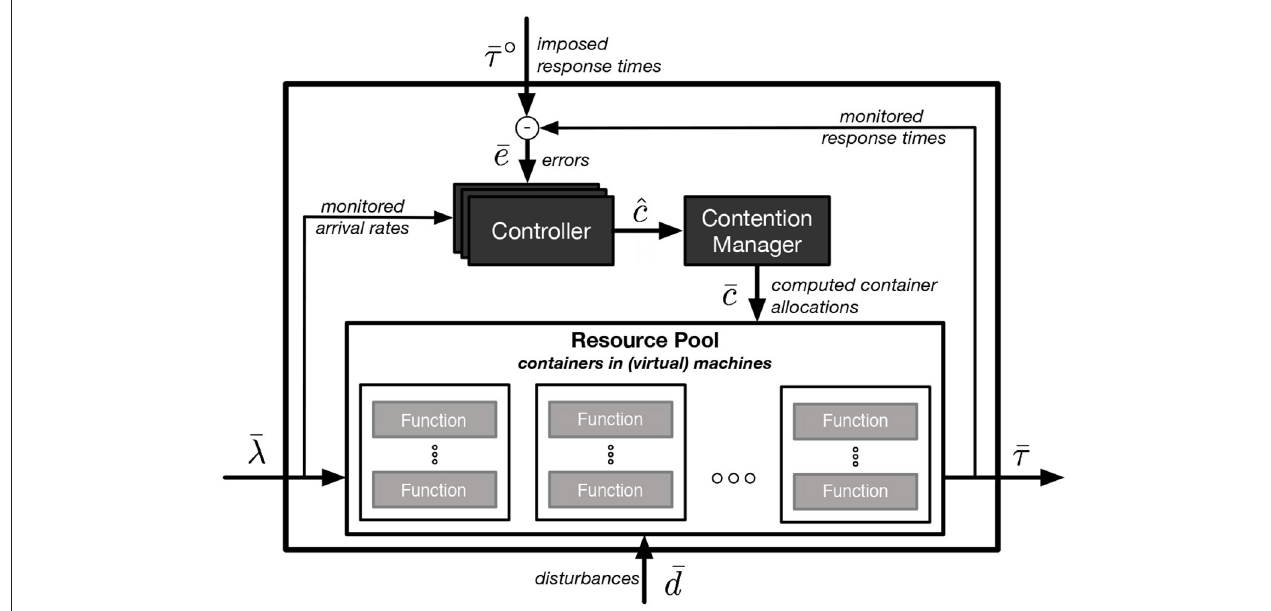
FIGURE 3 | Node-level control